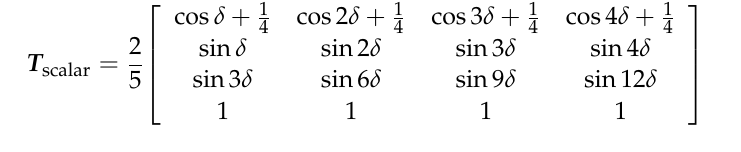
Figure 4. Block diagram of unified open-line fault-tolerant control for all connections. In this way, the post-fault torque performance can be maintained as stable enough by merely using open-loop voltage control. The involved matrices for this decoupled FTC are referred to in (1)–(3) [28]. In addition, in the figure, e A /2 is introduced to compensate for the oscillating neutral voltage post fault, which must be used in combination with T scalar to ensure the line voltage modulation work as anticipated [29]. It has to be emphasized that e A corresponds to the line-to-neutral back-EMF, and it is easy to acquire/estimate with merely rotor flux linkage parameters. The acquisition of e A under penta-connection modes is detailed in the section below.